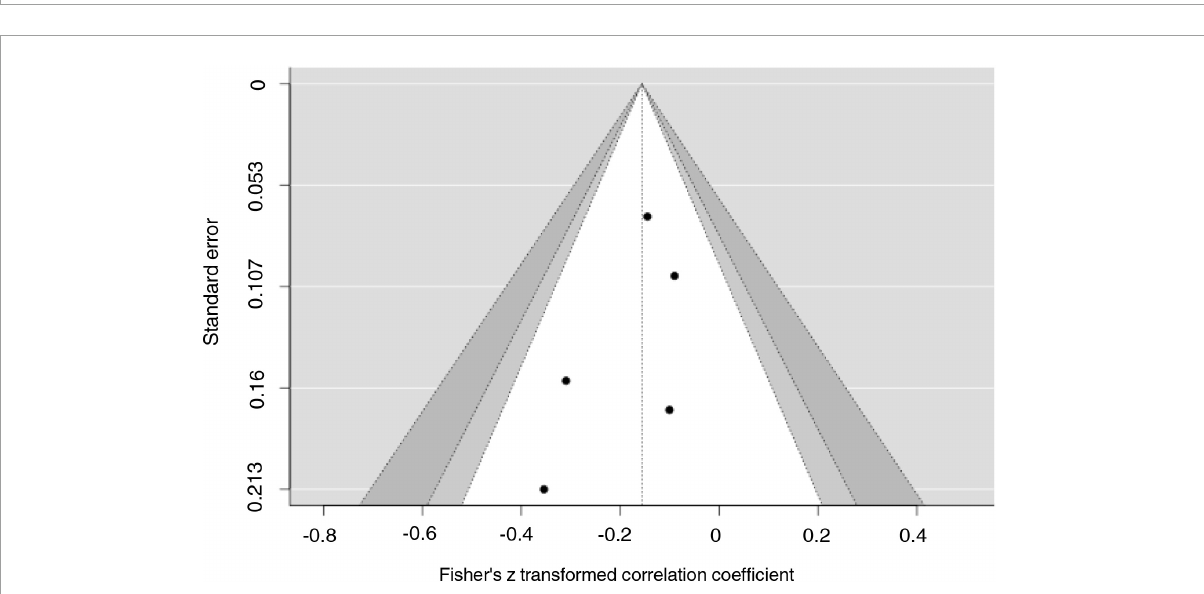
FIGURE3 Funnel plot. Estimates ( z -score) from selected studies (on the horizontal axes) plotted against each study’s standard error (on the vertical